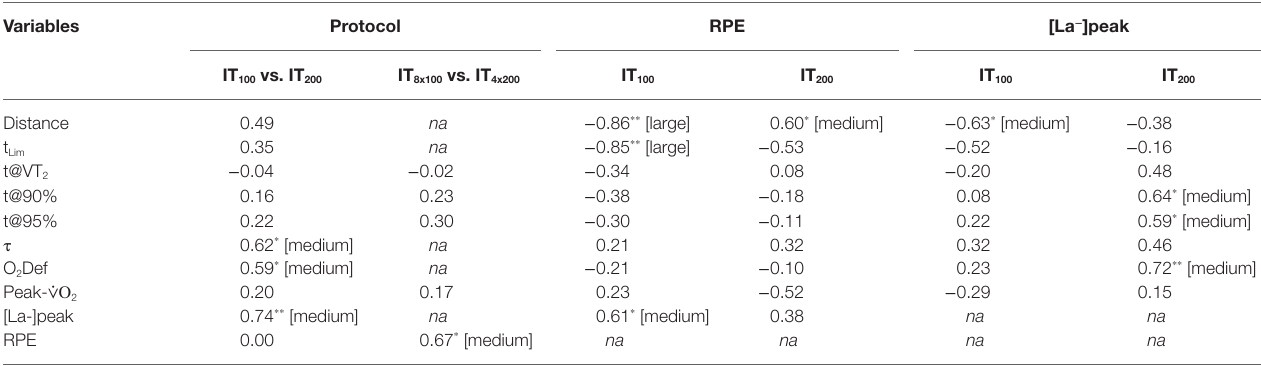
TABLE 5 | Spearman rank-order coefficients for the responses of temporal, physiological, and perceptual variables between the IT protocols. Variables